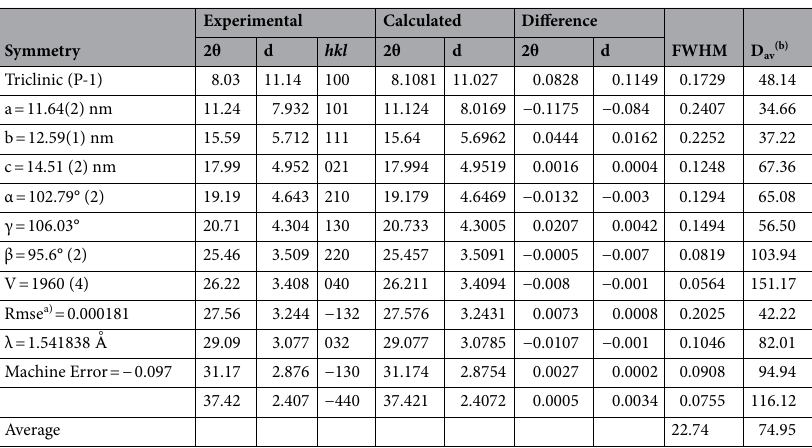
Table 2. The computing results from the Refine Version 3.0 Software Program (Kurt Barthelme’s and Bob Downs) for [ThiPy-3,8-Dc] Iso and [ThiPy-3,8-Dc] TF . (a) Root means square error.